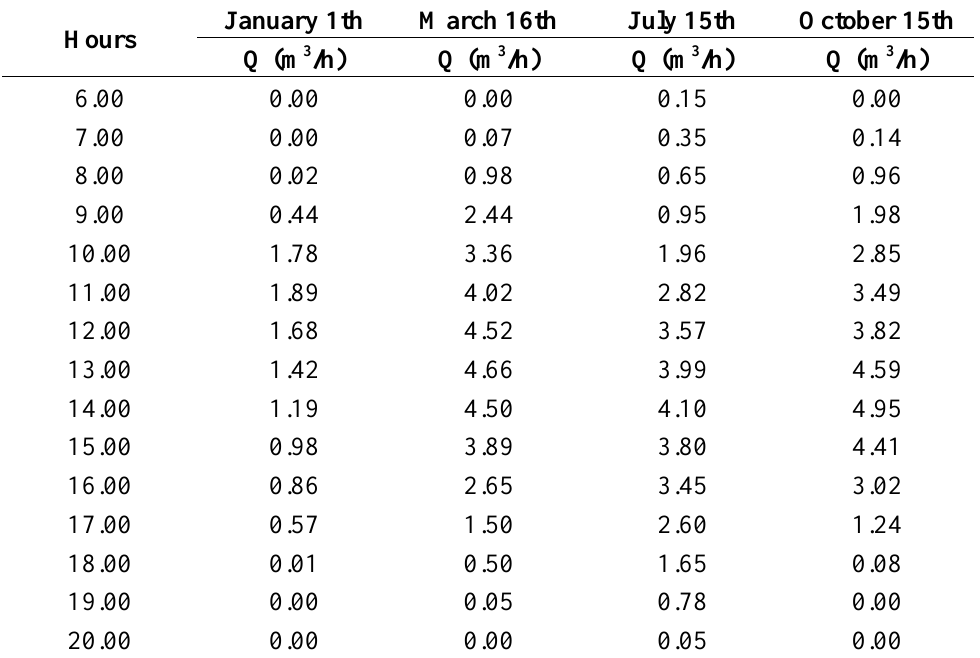
Table 6. Measured water flow rate for the pvwps in January 1th, March 16th, July 15th, October 15th, 2009 (Om Chraket station).